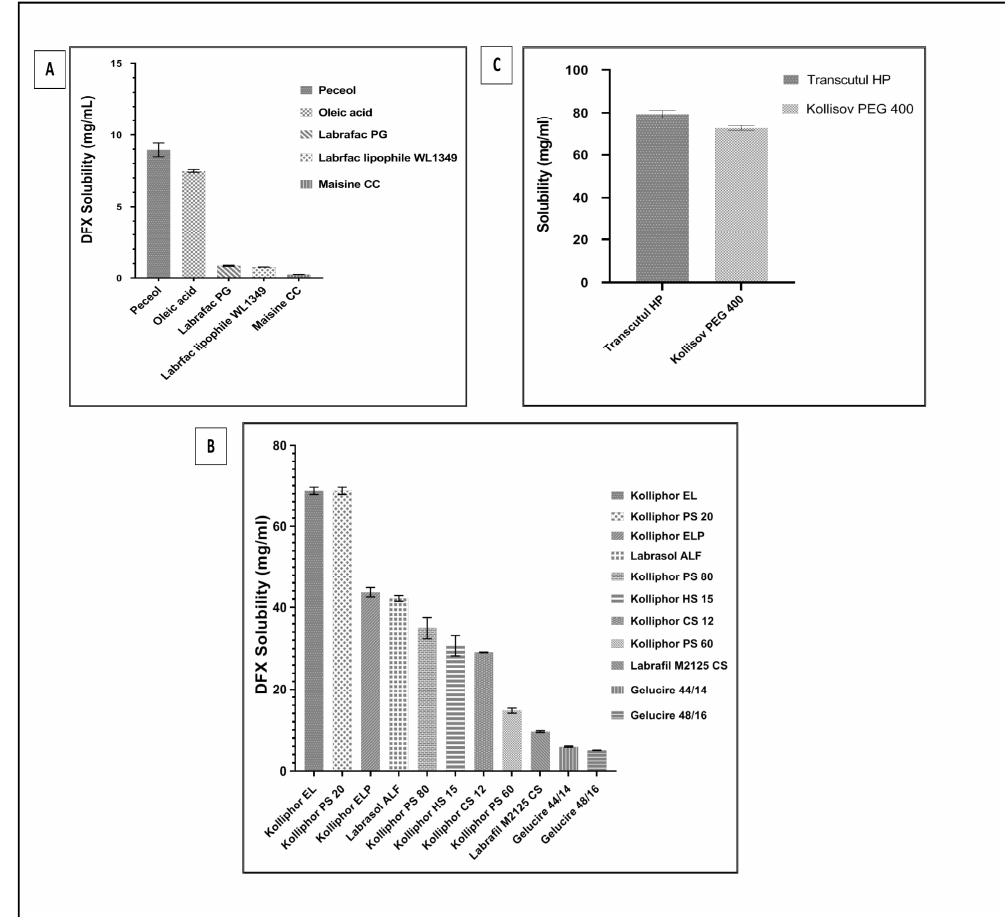
Figure 1. The solubility of deferasirox (DFX) in ( A ) different types of oils, ( B ) different types of surfactants, and ( C ) different types of co-surfactants. Each value represents the mean ± SD ( n = 3).